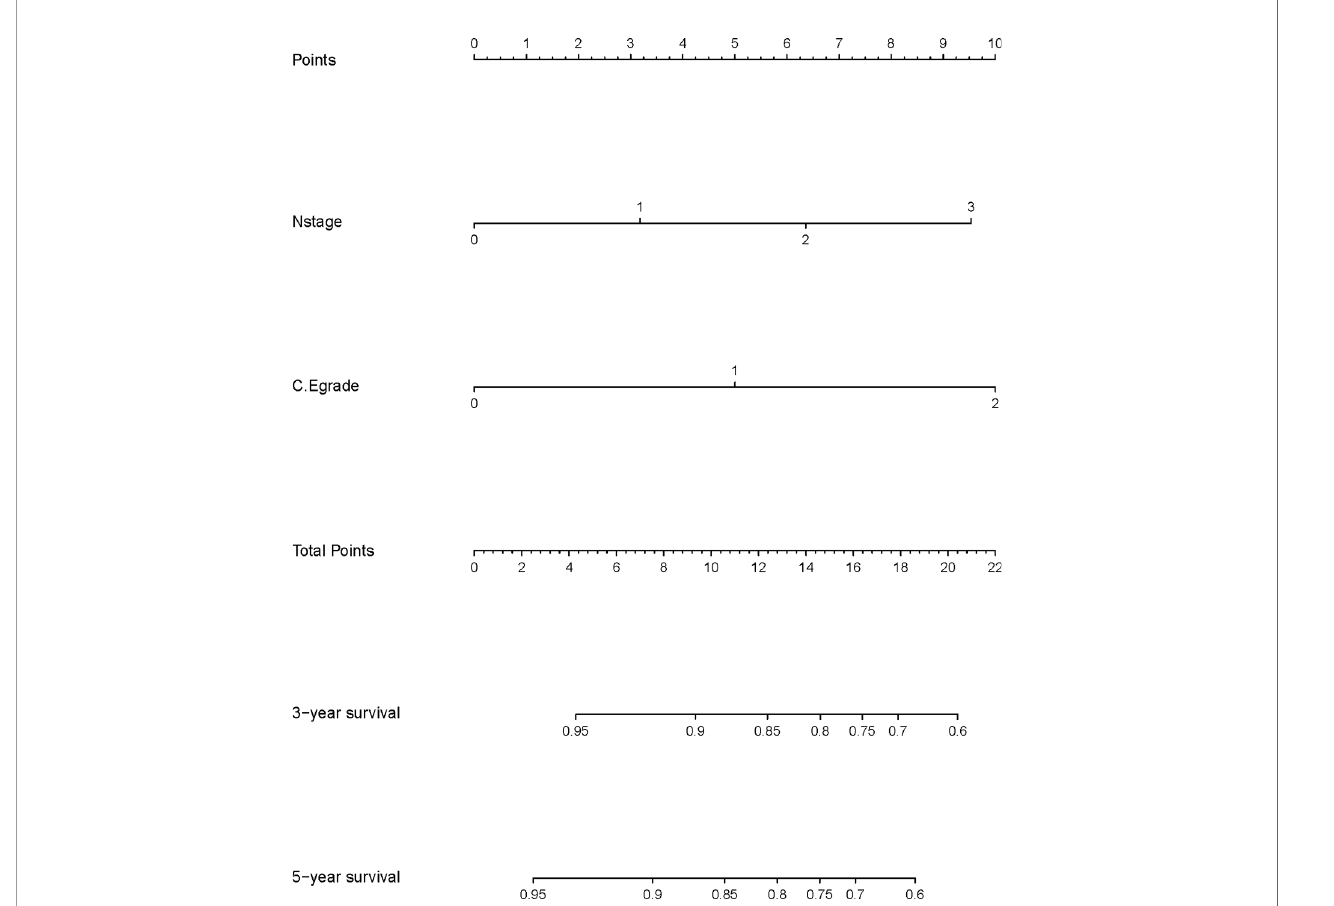
FIGURE 4 | A nomogram predicting the 3- and 5-year distant metastasis-free survival of NPC